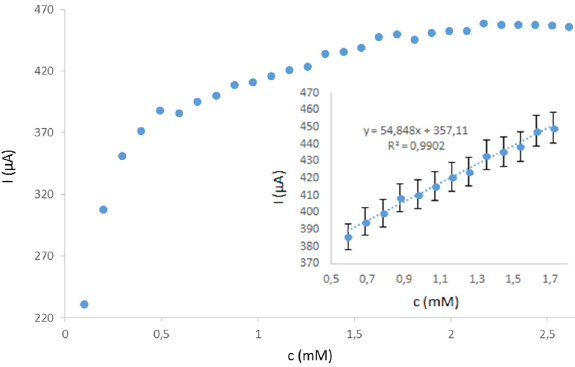
Figure 10: E ff ect of lactose concentration on response and linear working range ( insider graph ) for the modi fi ed electrode at + 0.12 V in range of − 0.1 to 1.0 V applied potential, pH 6.7.